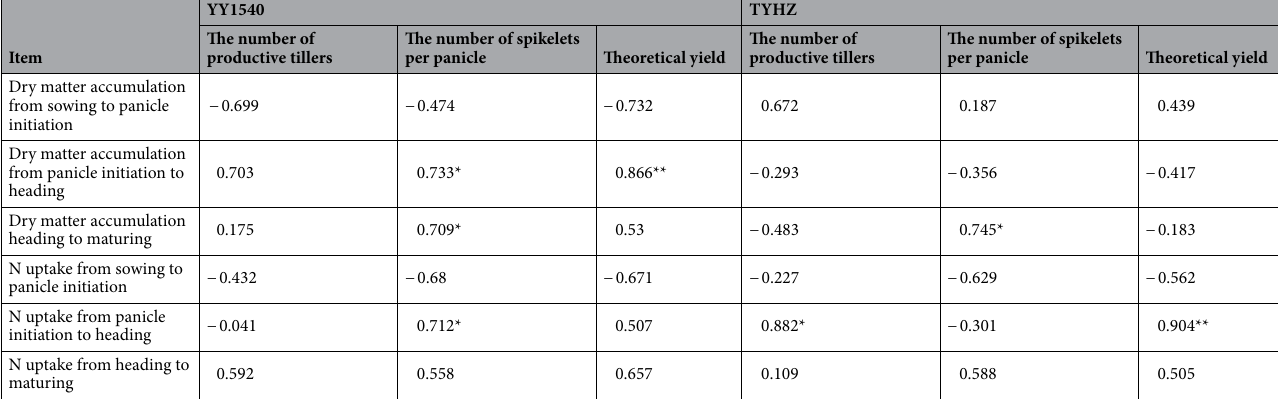
Table 6. Correlation analysis between dry matter accumulation and nitrogen uptake in indica – japonica hybrid rice (‘Yongyou1540’, YY1540) and indica hybrid rice (‘Tianyouhuazhan’, TYHZ). * p < 0.05; ** p <